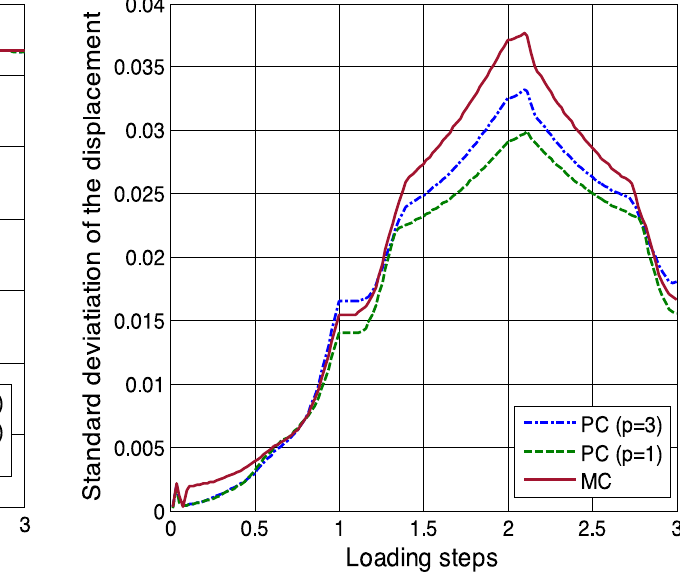
Fig. 10. Mean value of the displacement. Fig. 11. Standard deviation of the displacement.